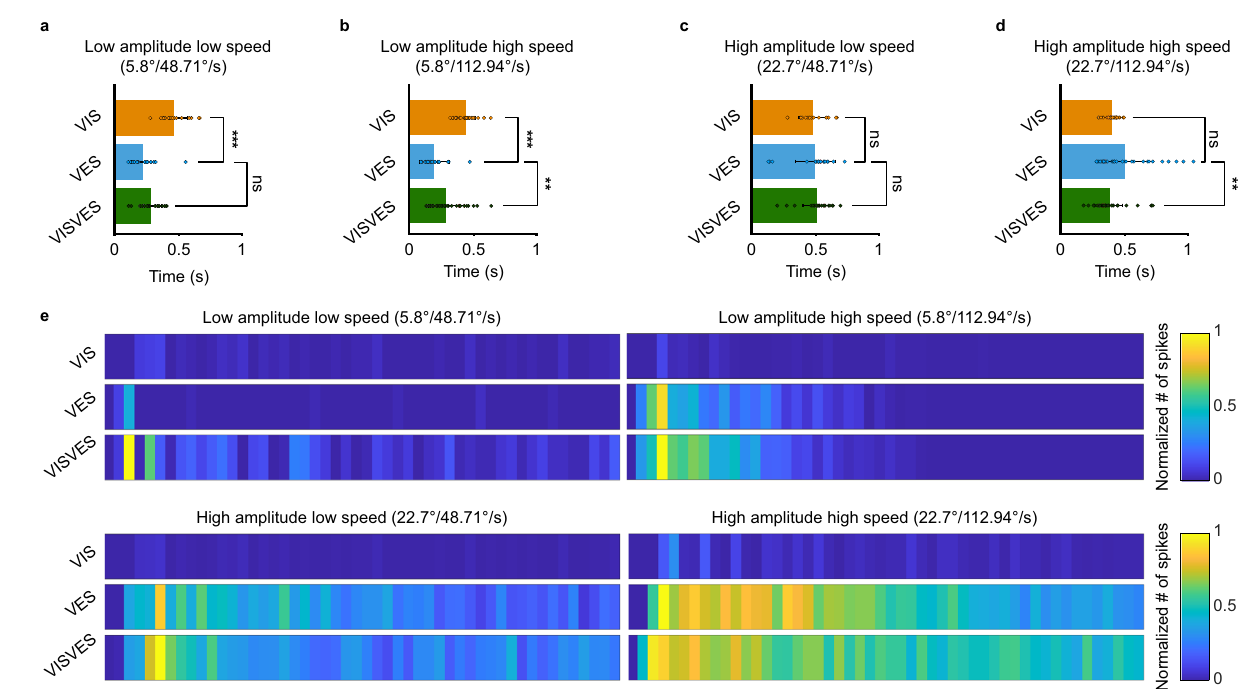
Fig.4|Temporaldynamicsofvisuo-vestibularintegration.a – d Graphsshowing the average time taken to reach the peak EMG amplitudefor each modality during the different paradigms. Paired T-tests yielded signi fi cance results for: Low ampli- tude low speed (VIS to VES t(16)=5.506, p <0.001, n =17 recordings from eight animals), Low amplitude high speed (VIS to VES t(23)=10.871, p <0.001, n =24 recordings from eleven animals and VES to VISVES t(30)= − 3.411, p =0.002, n =31 recordings from eleven animals), High amplitude high speed (VES to VISVES t(28)=2.818, p =0.009, n =29 recordings from twelve animals). e Heat maps